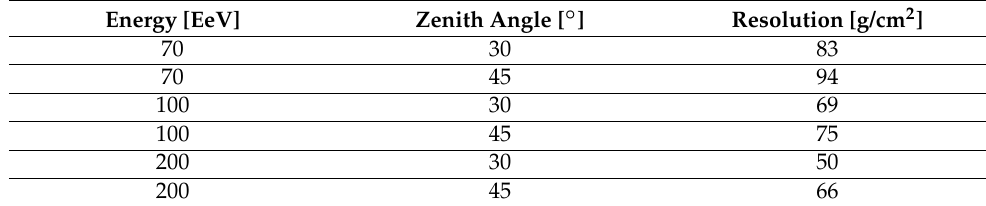
Table 3. X max resolution of the K-EUSO detector in the center of the field of